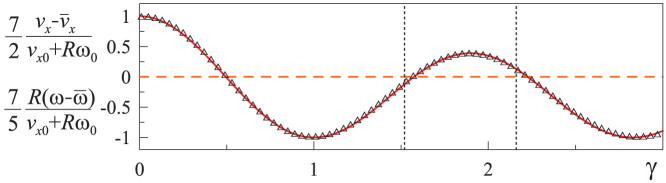
Dependencies of the variables ,  on the parameter  in the range of most interest for isotropic materials are shown with solid line.The range 1.52 < γ < 2.16 corresponding to Poisson number between −1 and 0.5 is marked by vertical dotted lines. The approximation (29) is shown with triangles; the classical, rigid-body solution (5), (6) is shown by the horizontal dashed line. The coefficient of determination for approximation (29) and numerical dependency in the full showed range of 0 < γ <3 is R2 > 0.9995.